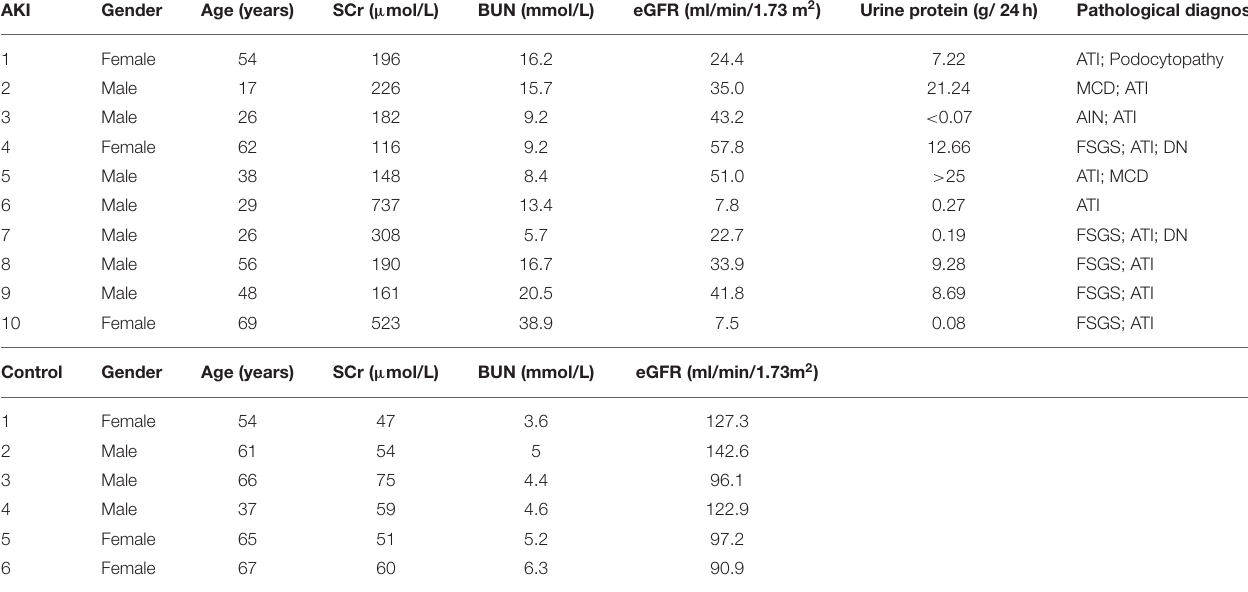
TABLE 1 | Clinical parameters of AKI patients and normal